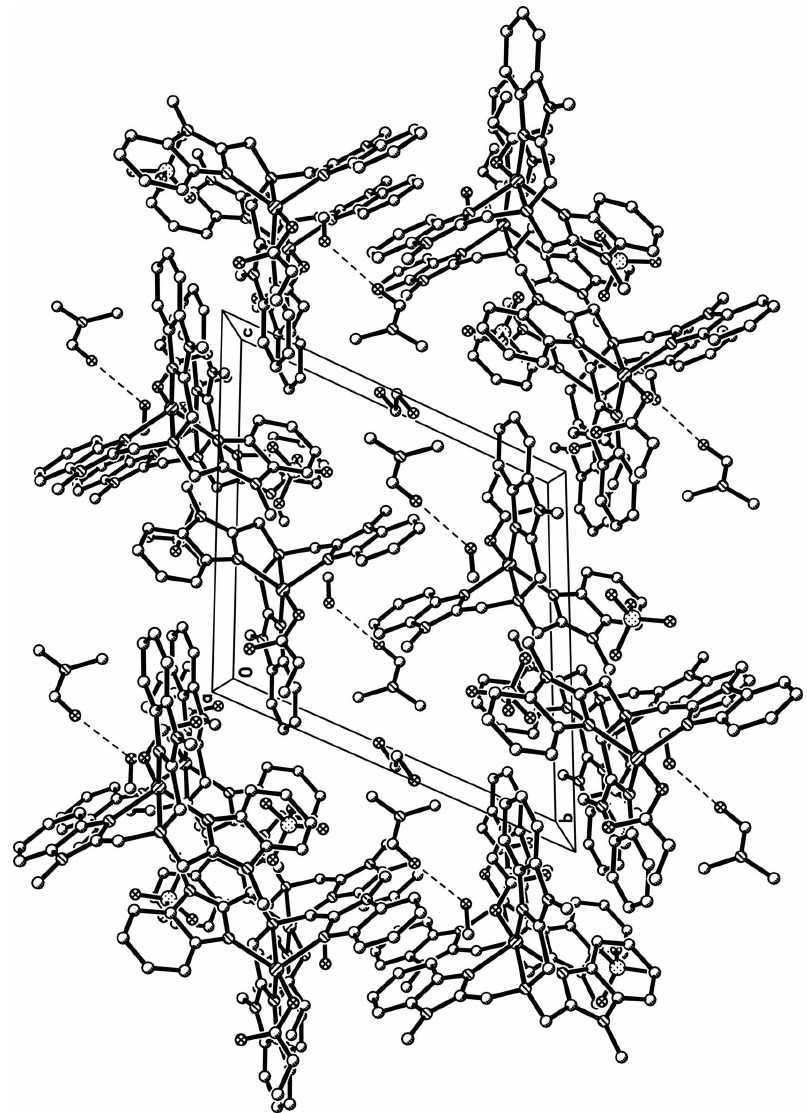
The Packing of the title compound. H atoms are omitted for clarity. The donor-acceptor distances of hydrogen bonds are shown as dashed lines. The disorder is not